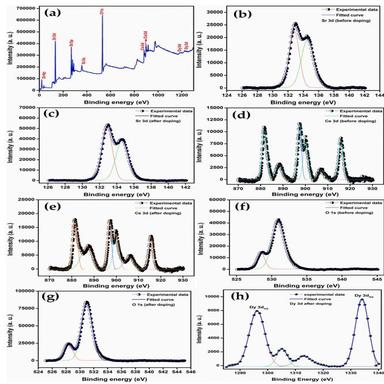
TEM images of (a–c) SCD7 NPs with different magnifications. Fig. 7. XPS measurements of SCD0 and SCD5: (a) survey scan of SCD5, (b, c) Sr 3d, (d, e) Ce 3d, (f, g) O 1s (before, after), respectively. (h) Dy 4p after doping.